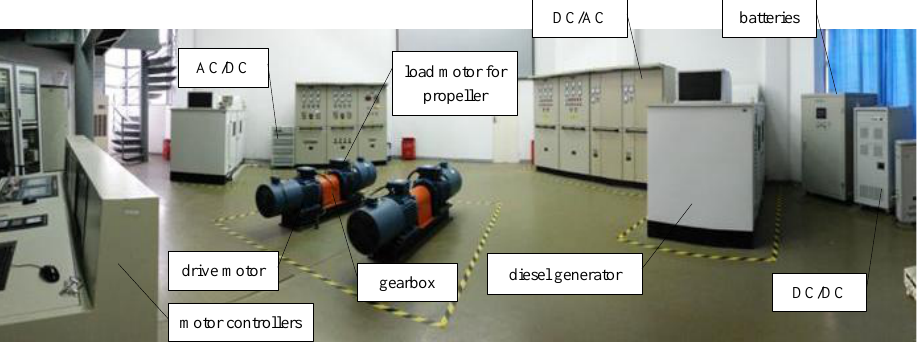
Figure 4. Hybrid ships’ experimental platform.